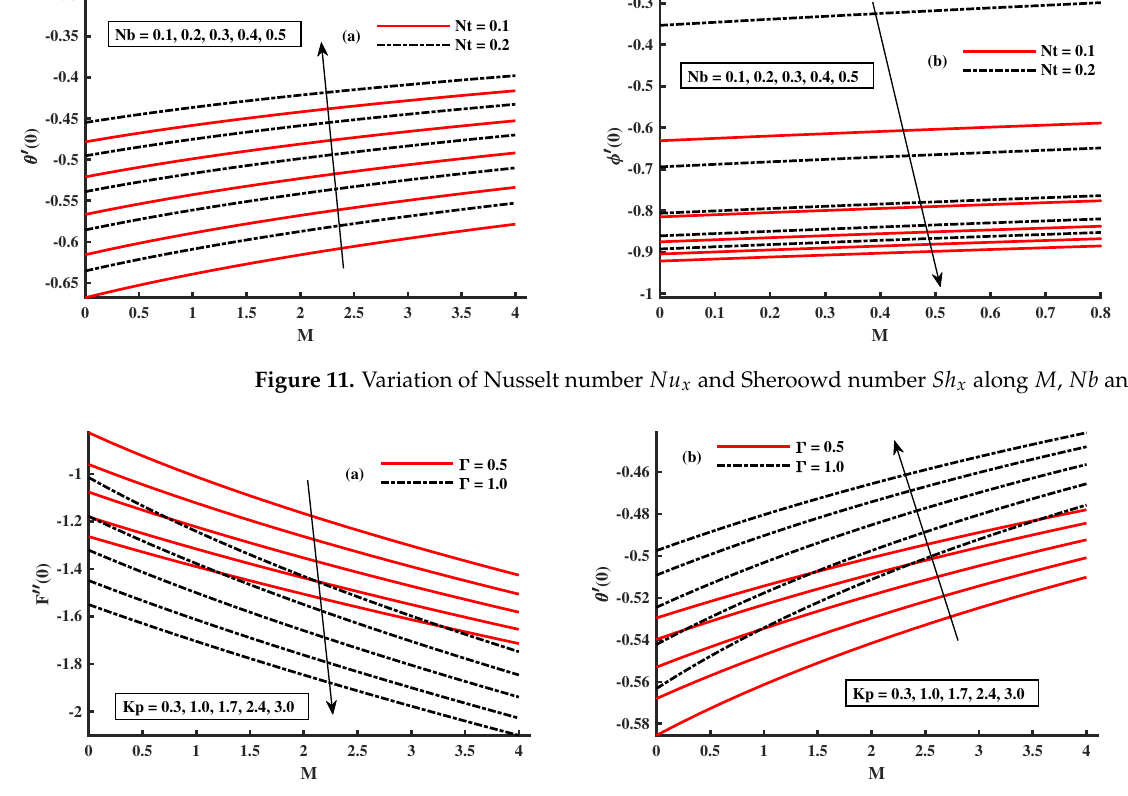
Figure 12. Variation of skin friction C fx and Nusselt number Nu x along M , K p and Γ